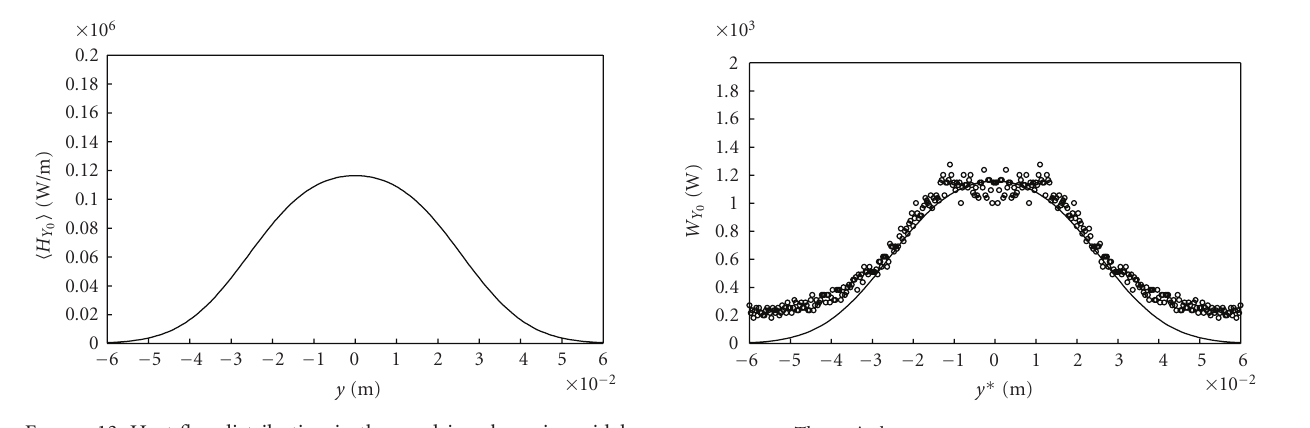
Figure 13: Heat flux distribution in the arc driven by a sinusoidal magnetic field. Y 0 is assumed as 2 . 2 × 10 − 2 m.